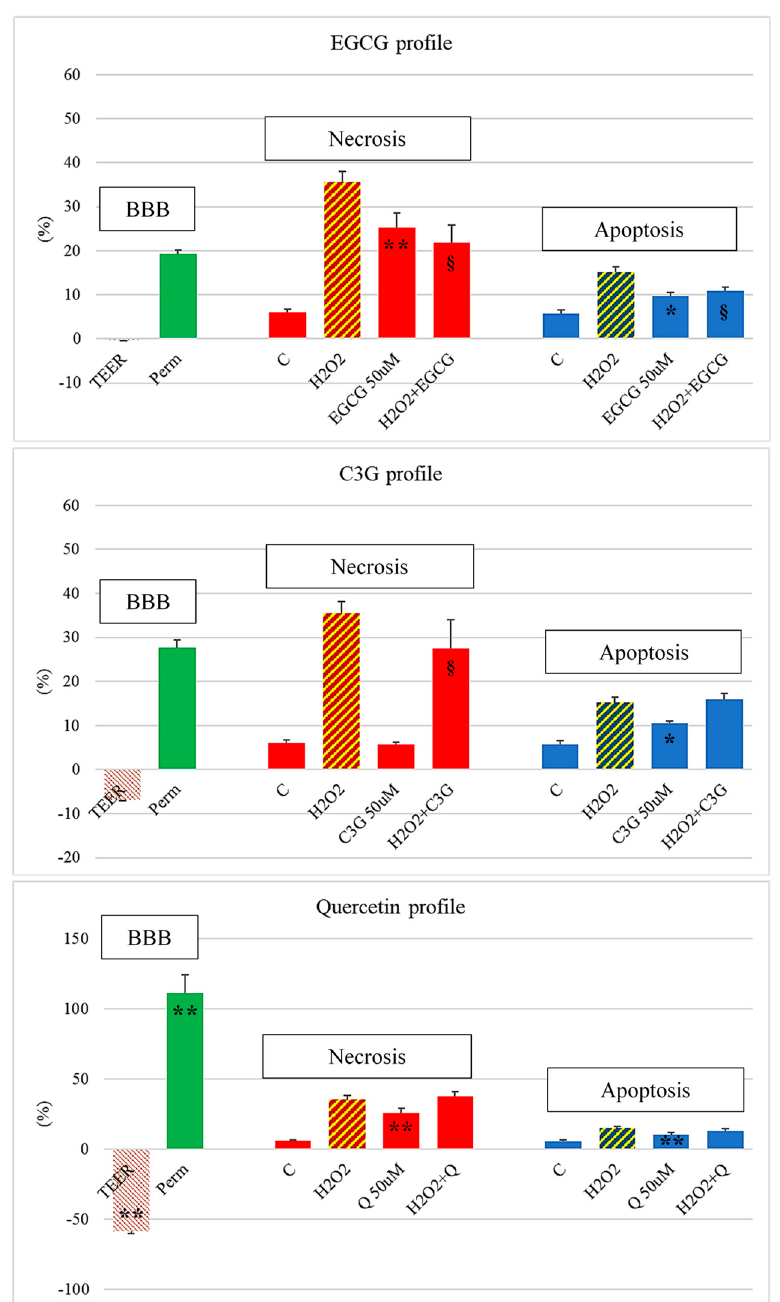
Figure 1. Neuroprotective and neurotoxic profile of epigallocatechin gallate (EGCG), cyanidin-3-glucoside (C3G), and quercetin (Q). Human brain microvascular endothelial cells (HBMEC) and rat-brain-neuron primary cultures were exposed to 50 µ M of selected polyphenols for 24 h alone or after previous 24 h exposure to 150 µ M H 2 O 2 . Controls were performed with respective culture media without H 2 O 2 (C) or with H 2 O 2 . Following incubation, transendothelial electrical resistance and Na-fluorescein permeability were measured in HBMEC, and neurons were stained with propidium iodide and Hoechst 33342 dyes to evaluate necrosis-like and apoptosis-like cell death, respectively [45]. * p < 0.05 and ** p < 0.01 vs. control; § p < 0.05 vs. H 2 O 2 .